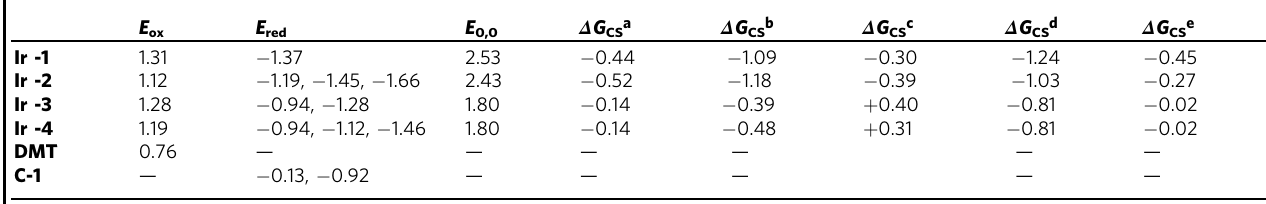
The potential values are given with respect to saturated calomel electrode (SCE) ( F c as internal reference, E 1/2(Fc + /Fc) =+ 0.40V vs. SCE) Δ G CS representsthevalueofthechangeinGibbsfreeenergyfortheelectrontransferprocess: a from DMT toexcitedPS, b fromexcitedPStoCo 3 + ( C-1 ), c fromexcitedPStoCo 2 + ( C-1 ), d fromreducedPS to Co 3 + ( C-1 ), e from reduced PS to Co 2 + ( C-1